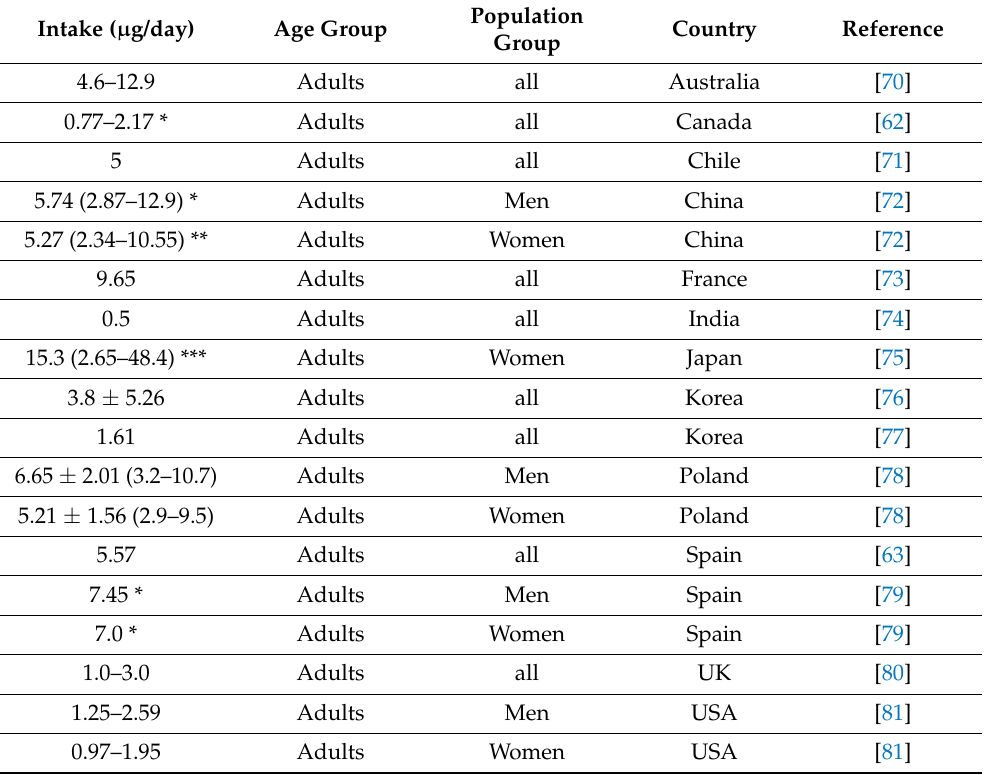
Table 4. Total mercury intake from selected country.